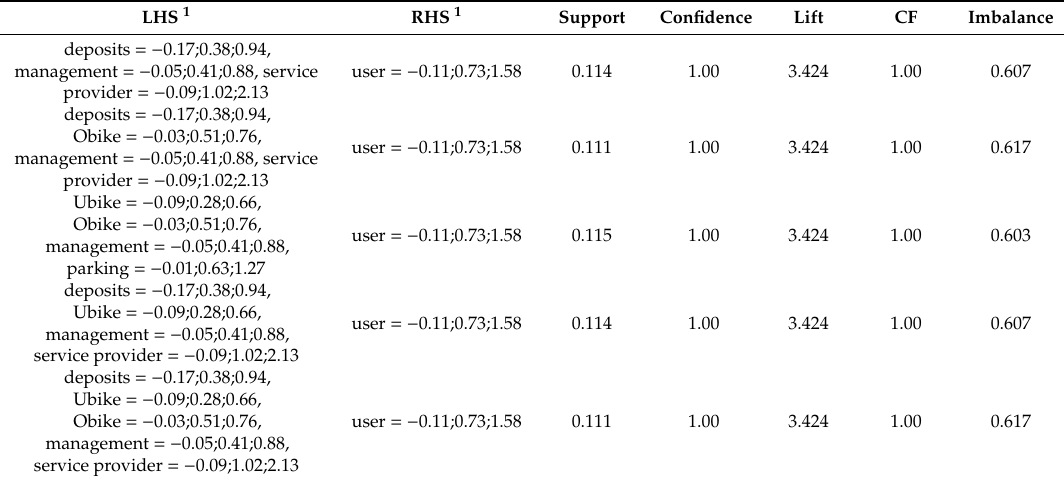
Table 4. Top five rules generated by the genetic fuzzy a priori algorithm.